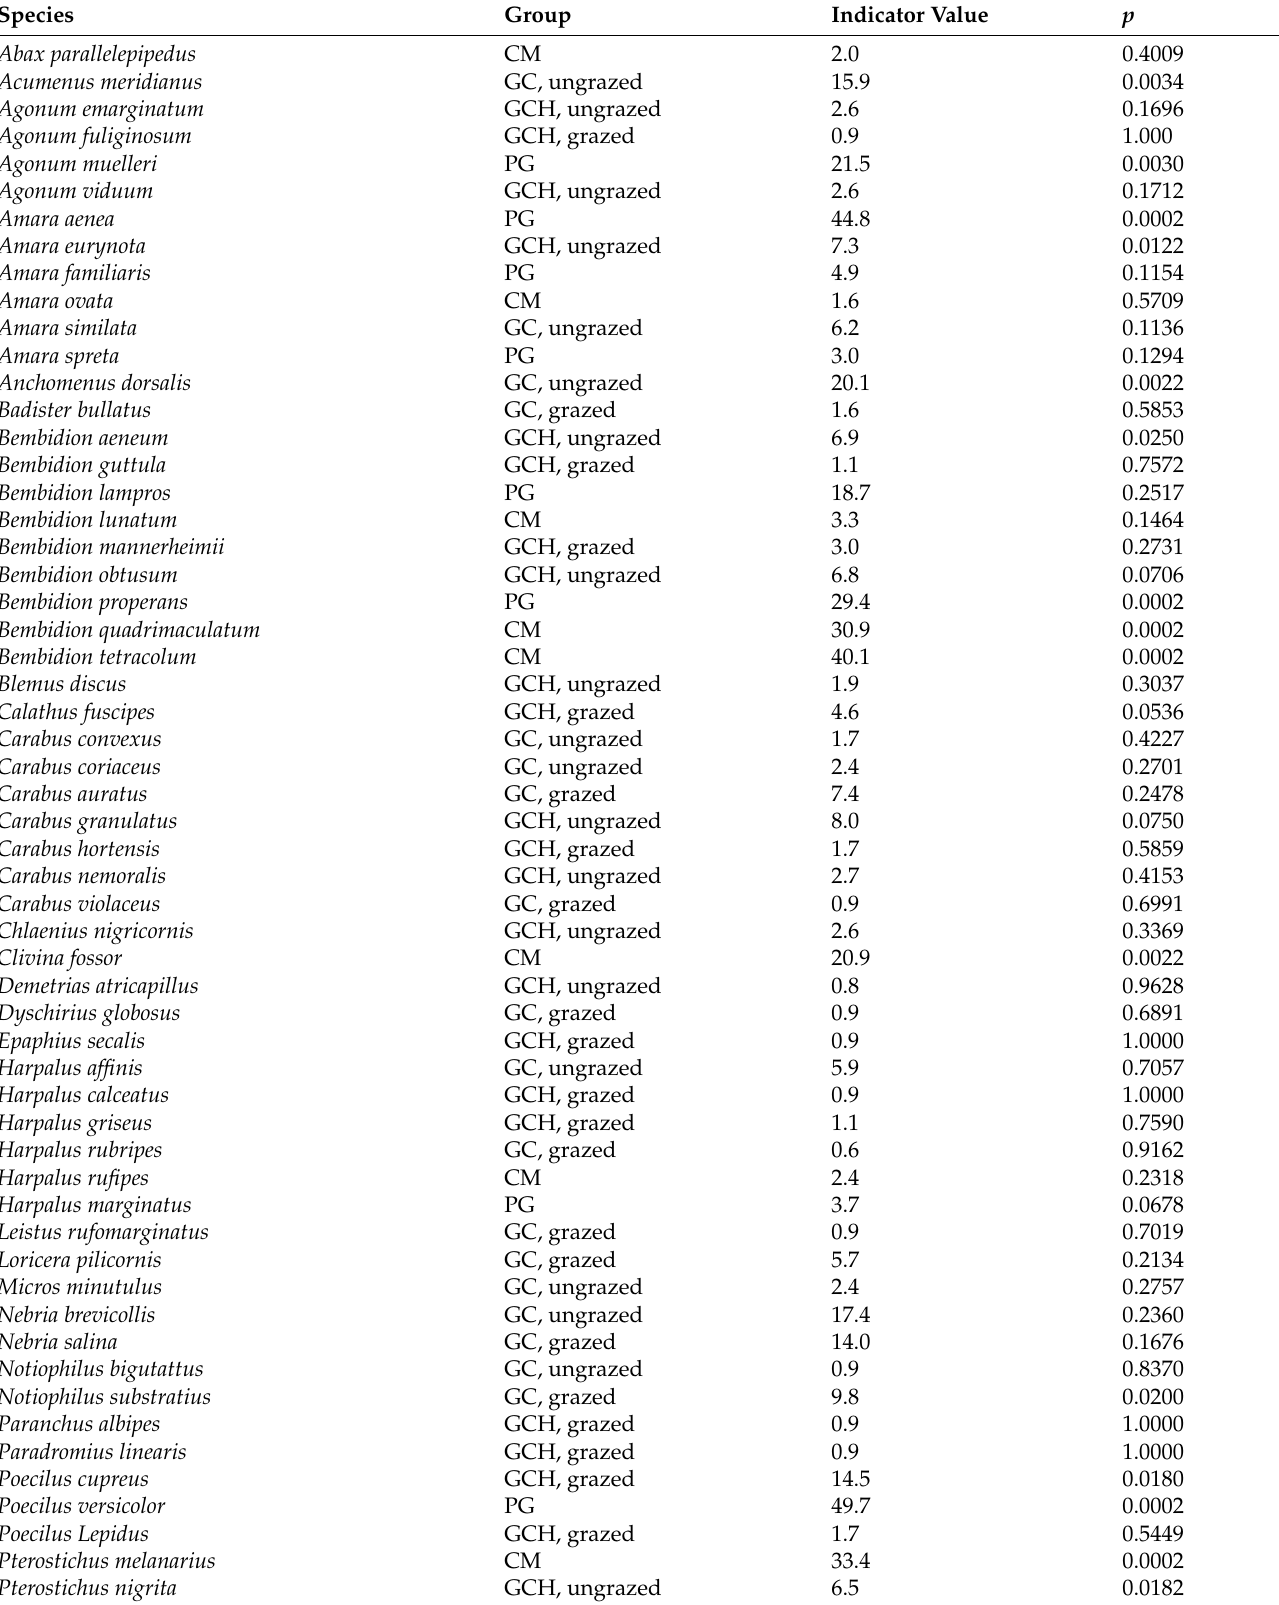
Table A2. Results of the indicator species analysis in May and June (CM: conventional maize, GC: grass–clover, GCH: grass–clover herbs, PG: permanent